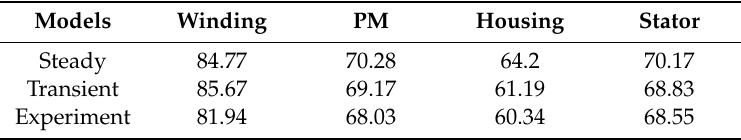
Table 3. Temperature Results ( ◦